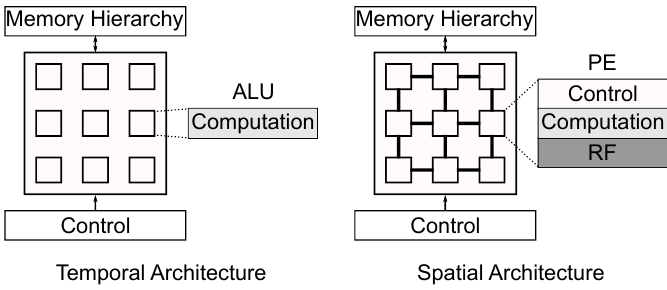
Figure 6. Comparison between the temporal and spatial